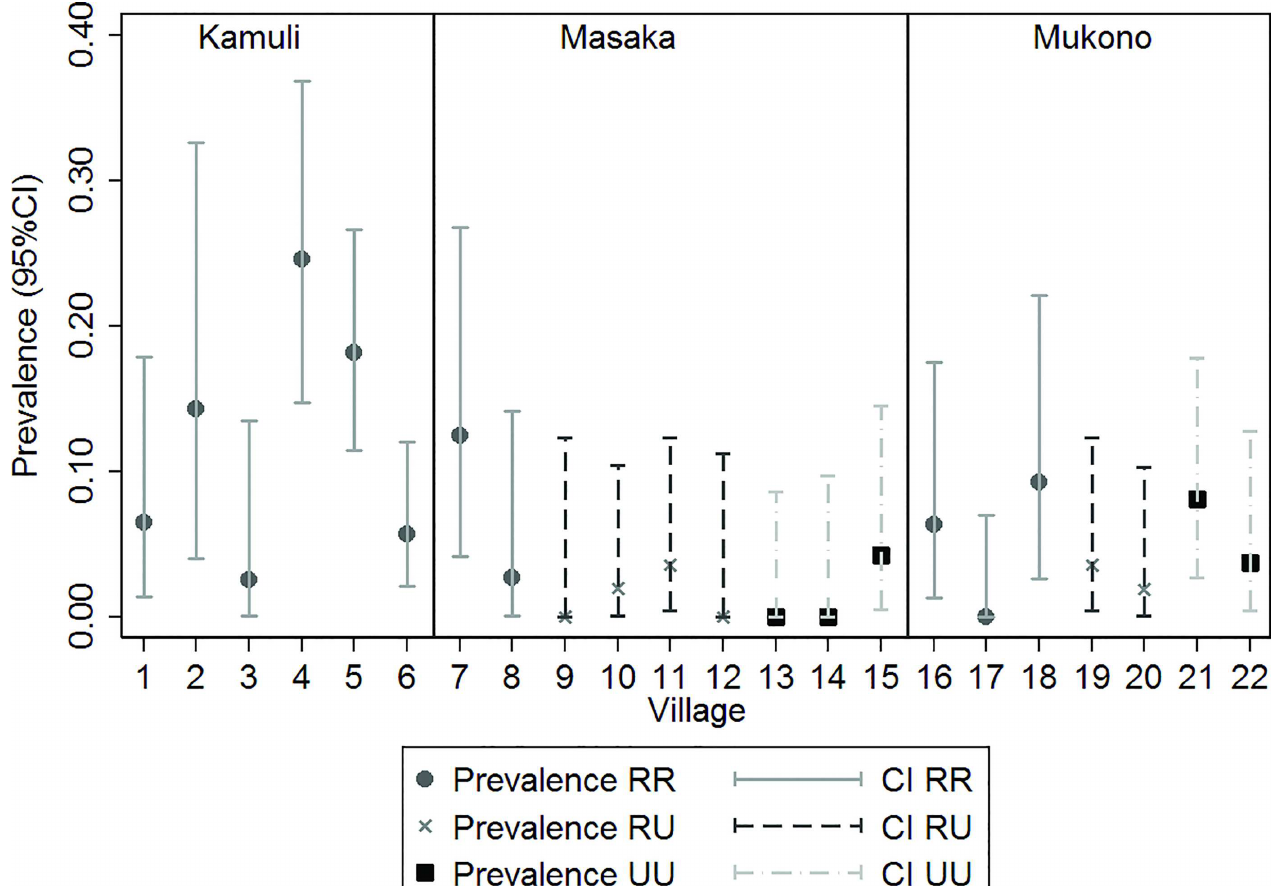
Fig 2. Prevalence estimatesand confidence levels for anti- Trichinella IgG (PrioCHECK Trichinella Ab) in three districts in Central and Eastern Uganda, sampled between April and July